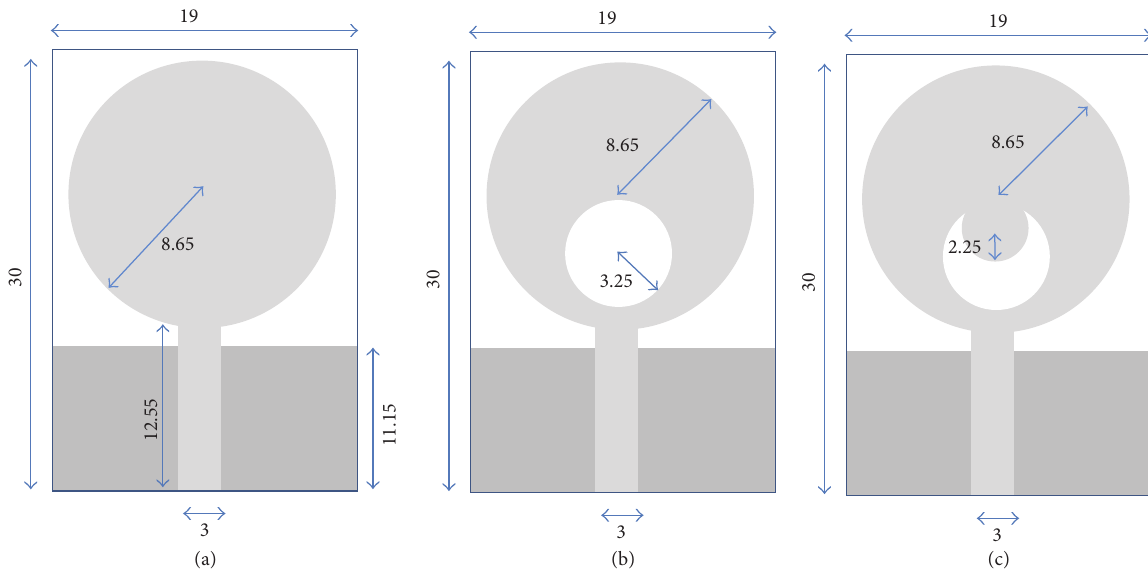
Figure 5: Design steps adopted to realize the UWB monopole antenna: (a) first step, (b) second step, and (c) third